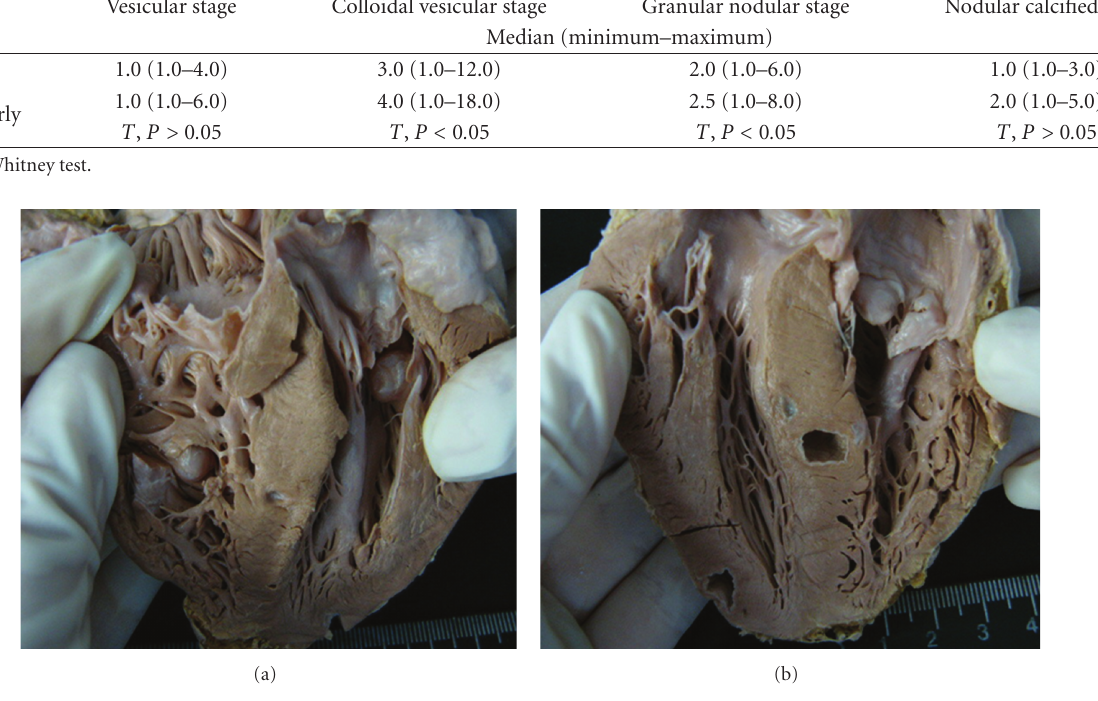
Figure 2: Cardiac cysticercosis in elderly individual. (a) Anterior view of the posterior half of organ showing two cysticerci in the endocardium. (b) Posterior view of the anterior half of organ showing cysticercus in the interventricular septum and in